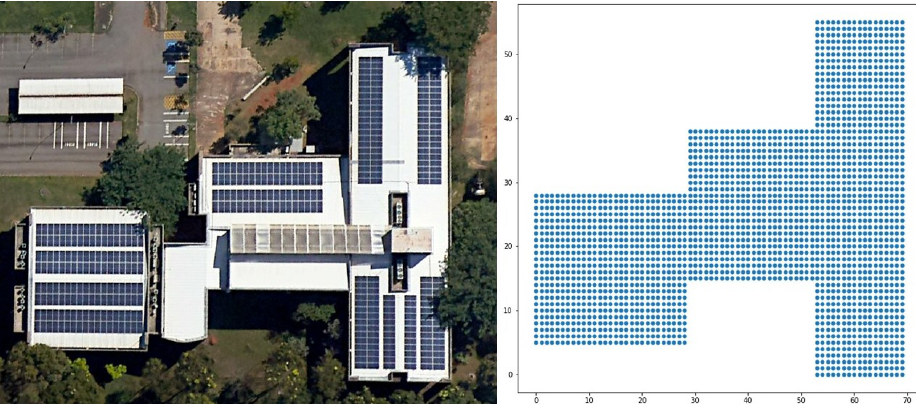
Figure 2. An example of area mapping using the Institute of Informatics,